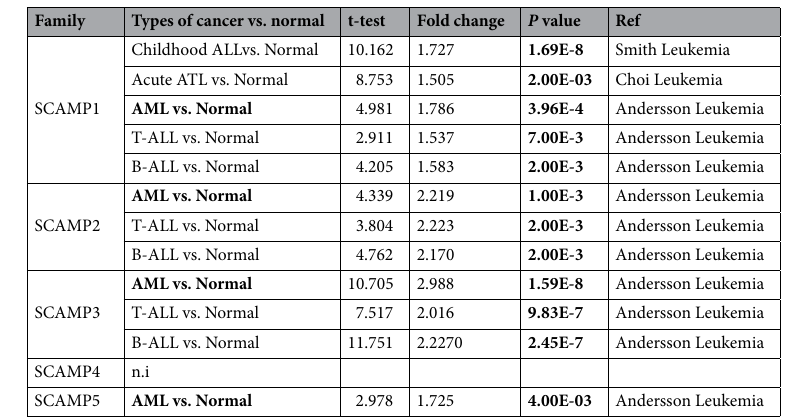
Table 1. The mRNA levels of SCAMPs in different types of leukemia (ONCOMINE). Bold values in the table represent statistical significance. (Threshold P -value < 0.05; fold change ≥ 1.5 and gene rank: all). n.i., no